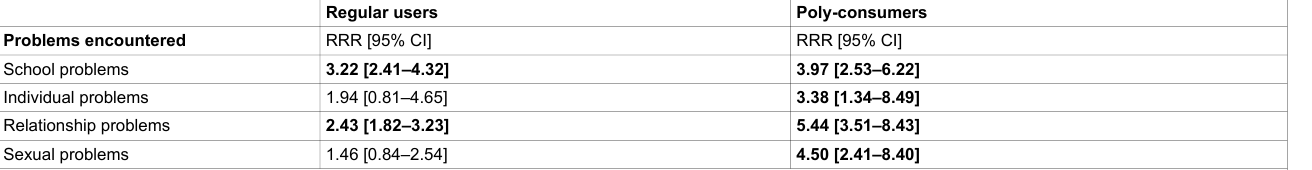
Table 4: Multivariate analysis a of substance-related problems according to IPS consumption